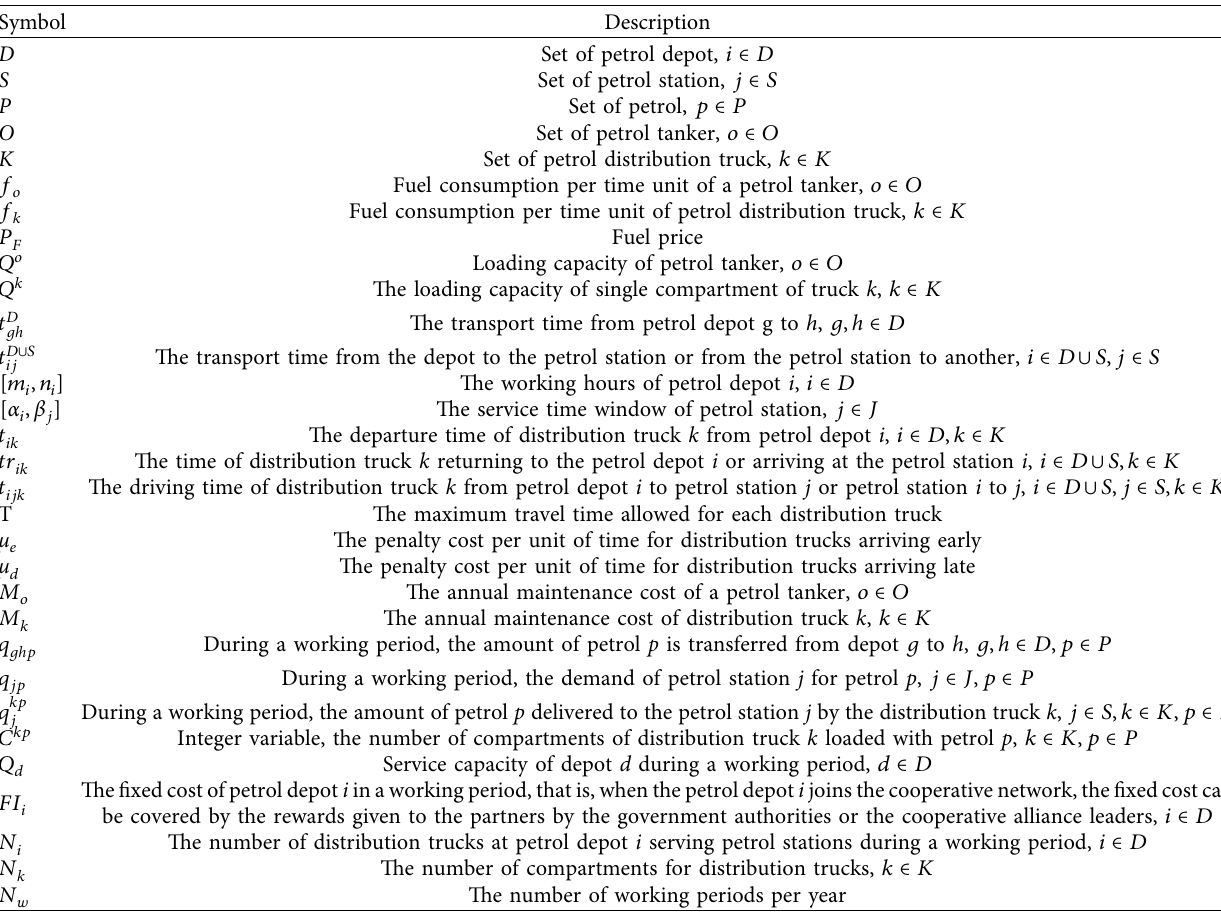
Table 2: Notations and definitions in CMPDVRPE.